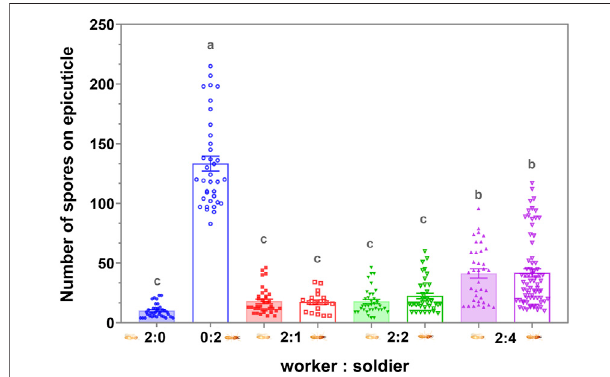
FIGURE 6 | Attachment and persistence of the Metarhizium anisopliae conidia on the termite cuticle 4 h postinfection. Data represent the mean ± standard error of the mean (SEM). A total of fi ve de fi ned dorsal epicuticle sites of each termite (head, thorax, 2nd, 4th, and 6th of abdominal segments) surface were counted for the attachment of the conidia. The numbers in the abscissa represent the numbers of infected workers and infected soldiers in each group, respectively. The data columns with different colors symbolized the different soldier and worker compositions. Groups consisting only of workers or soldiers were symbolized bythe blue. The data column of the solid color block indicated workers, and the hollow data column indicated the soldier. Different letters indicate signi fi cant differences among the eight sets of data (one-way ANOVAs, LSD, p < 0.05).